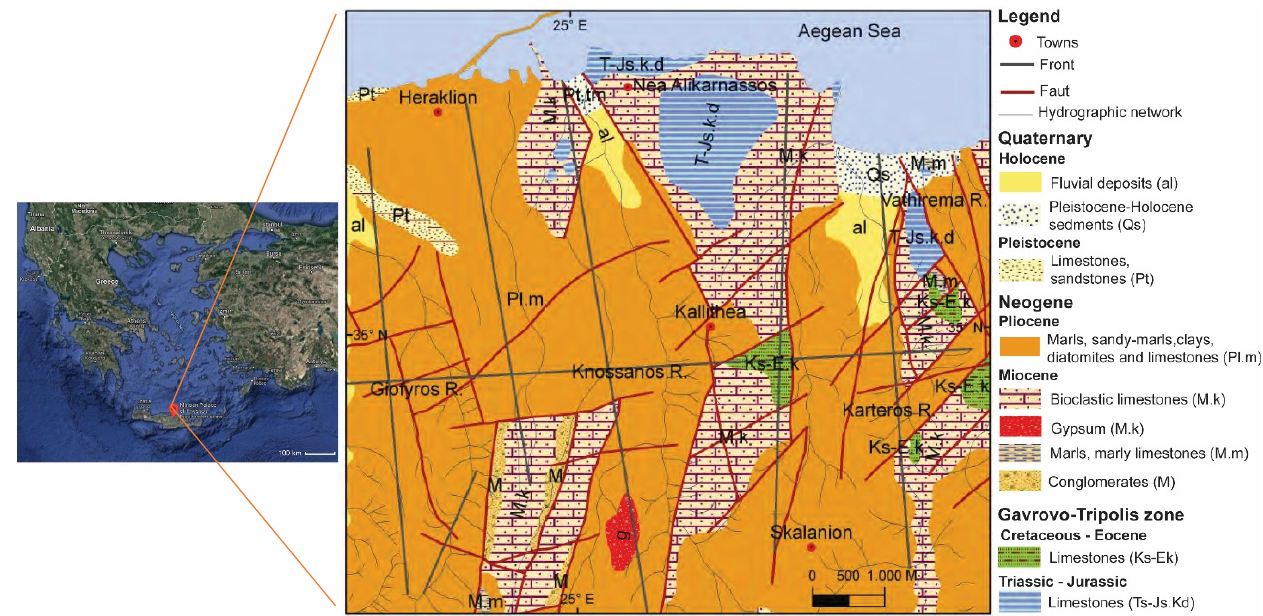
Figure 1. Localization of the Palace of Knossos, Crete, Greece (image/adapted from Google Maps, Maps data © 2021 Google). Geological map of Heraklion region (image/adapted from Kokinou, E. et al. (2013), p. 288 [26]).